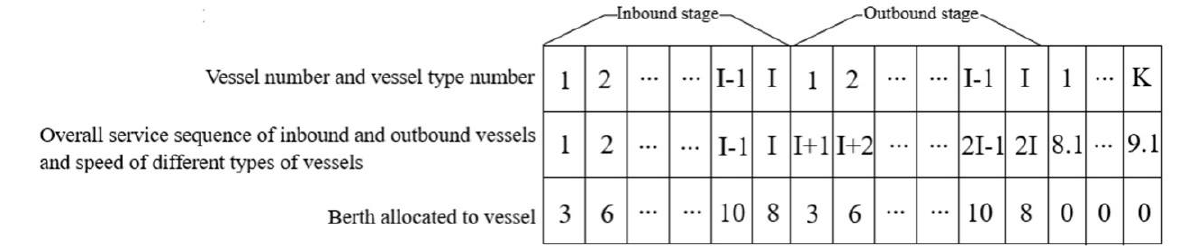
Figure 4. Genes and chromosomes.